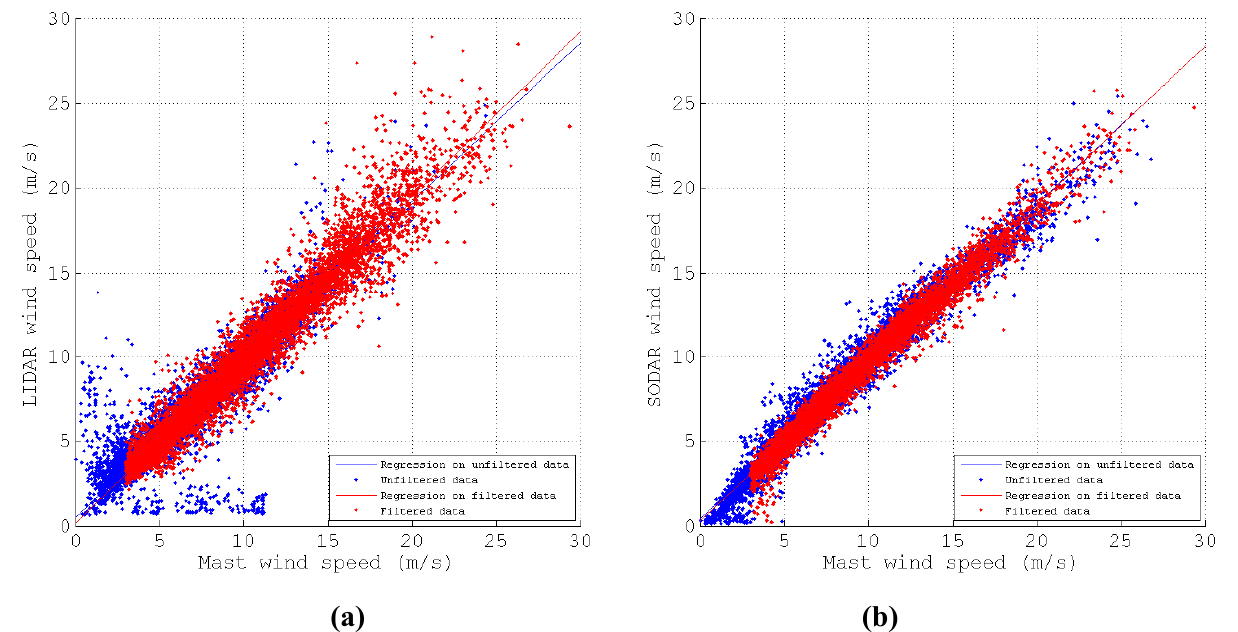
Figure 6. Comparison of 80 m wind speeds with WS1 cup anemometer (Mast): (a) LIDAR and cup; and (b) SODAR and cup, (February–May; 10 min averages).